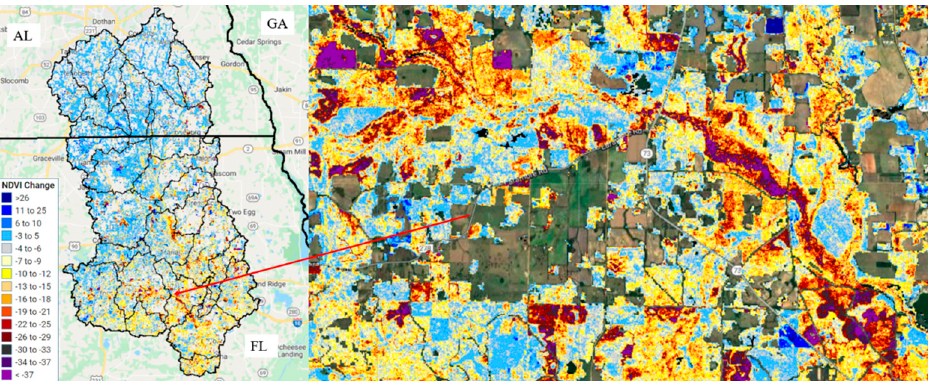
Figure 3. Change in growing season NDVI of forested lands between pre-storm (2018) and post- storm (2019–2020) periods within the Chipola River watershed using Google Earth Engine Sentinel 2 Level-2A data. NDVI change output is calculated as absolute change (NDVI value multiplied by 100). Satellite RGB images illustrate post-storm conditions, salvage harvesting, and riparian zone destruction. Within the highlighted areas NDVI levels of 0.77 before the storm dropped to 0.22 within the severely impacted (purple) areas following Hurricane Michael.